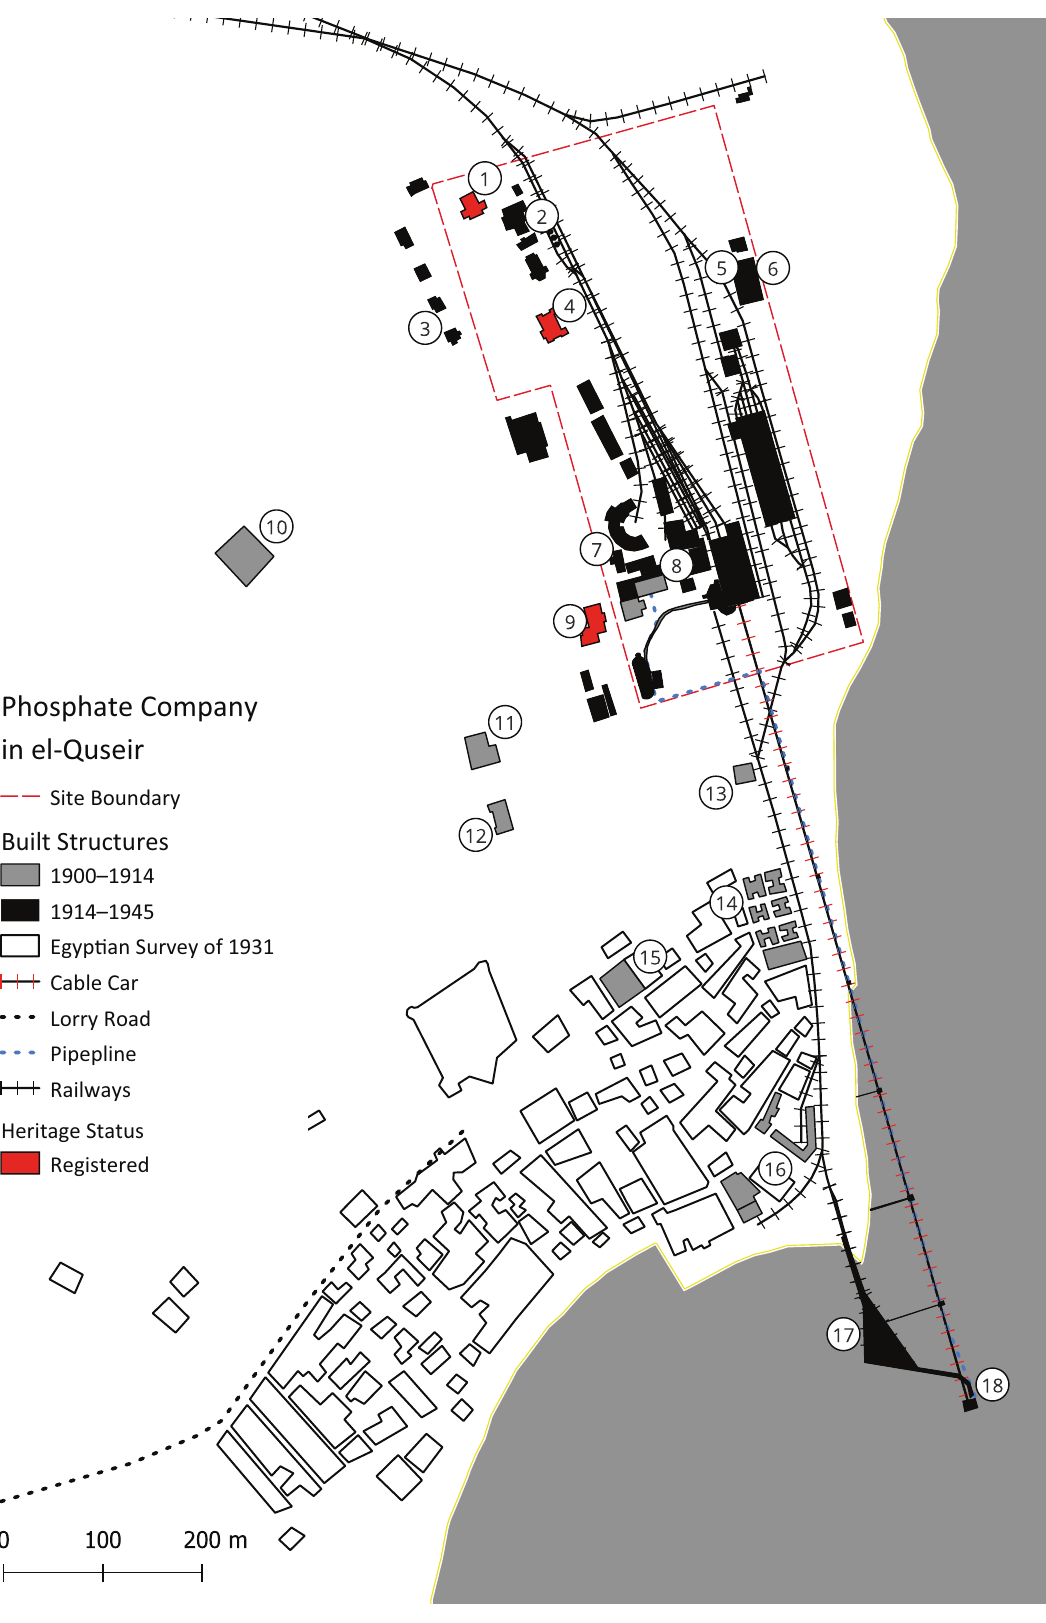
Figure 1. Map of el‐Quseir urban fabric and the coastal phosphate plant in 1930–1940 (black outline), highlighting the integrated buildings of Phase 1 (until 1914, grey) and the detached plant (1914 and after, black) and currently registered heritage buildings (red). Source: Created by the authors with the use of base map (Egyptian Survey of 1931), as reproduced in Le Quesne